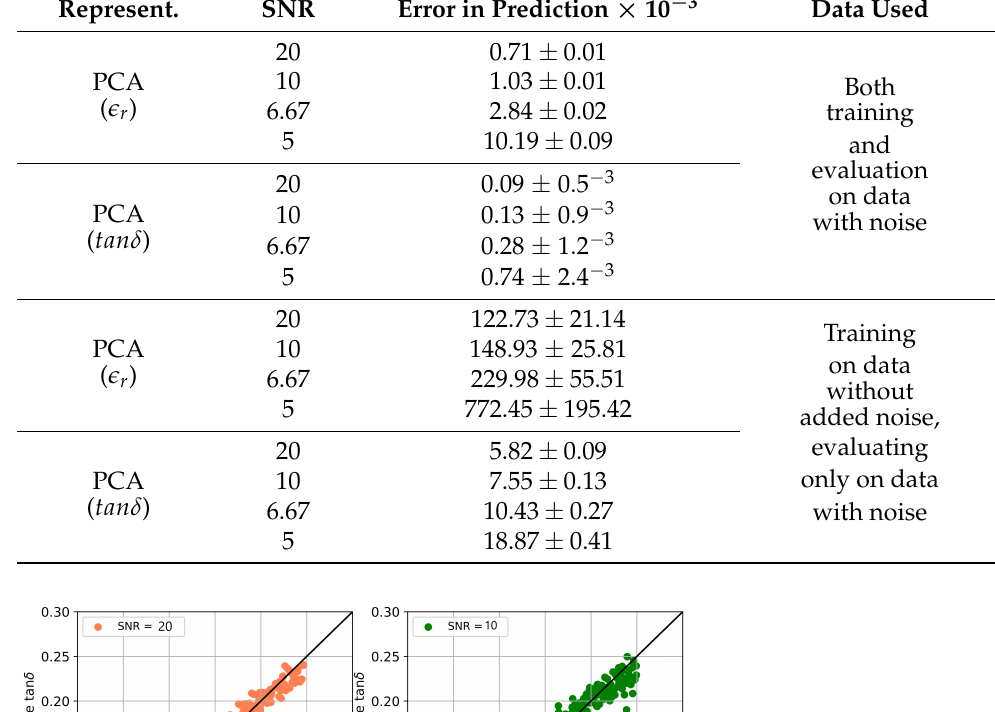
Table 5. Parameter estimation error with noise added to the generator signal. Represent.